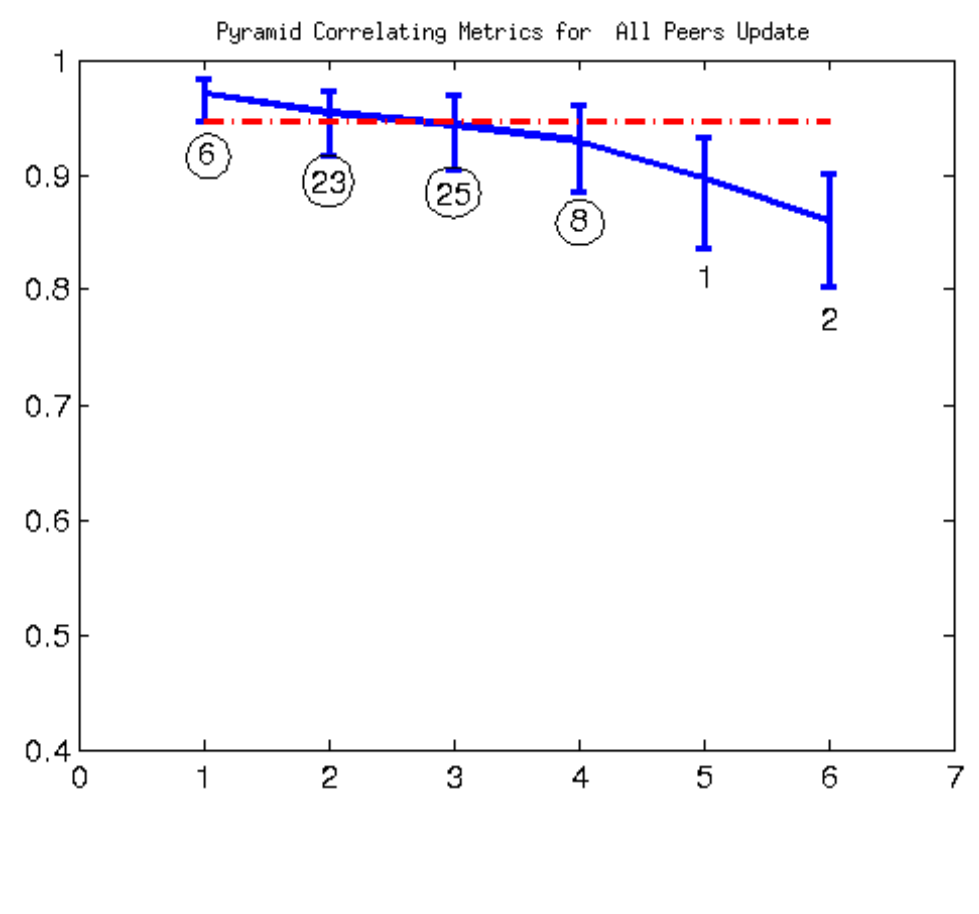
Figure 8. Pearson correlation with pyramid all peers and no models